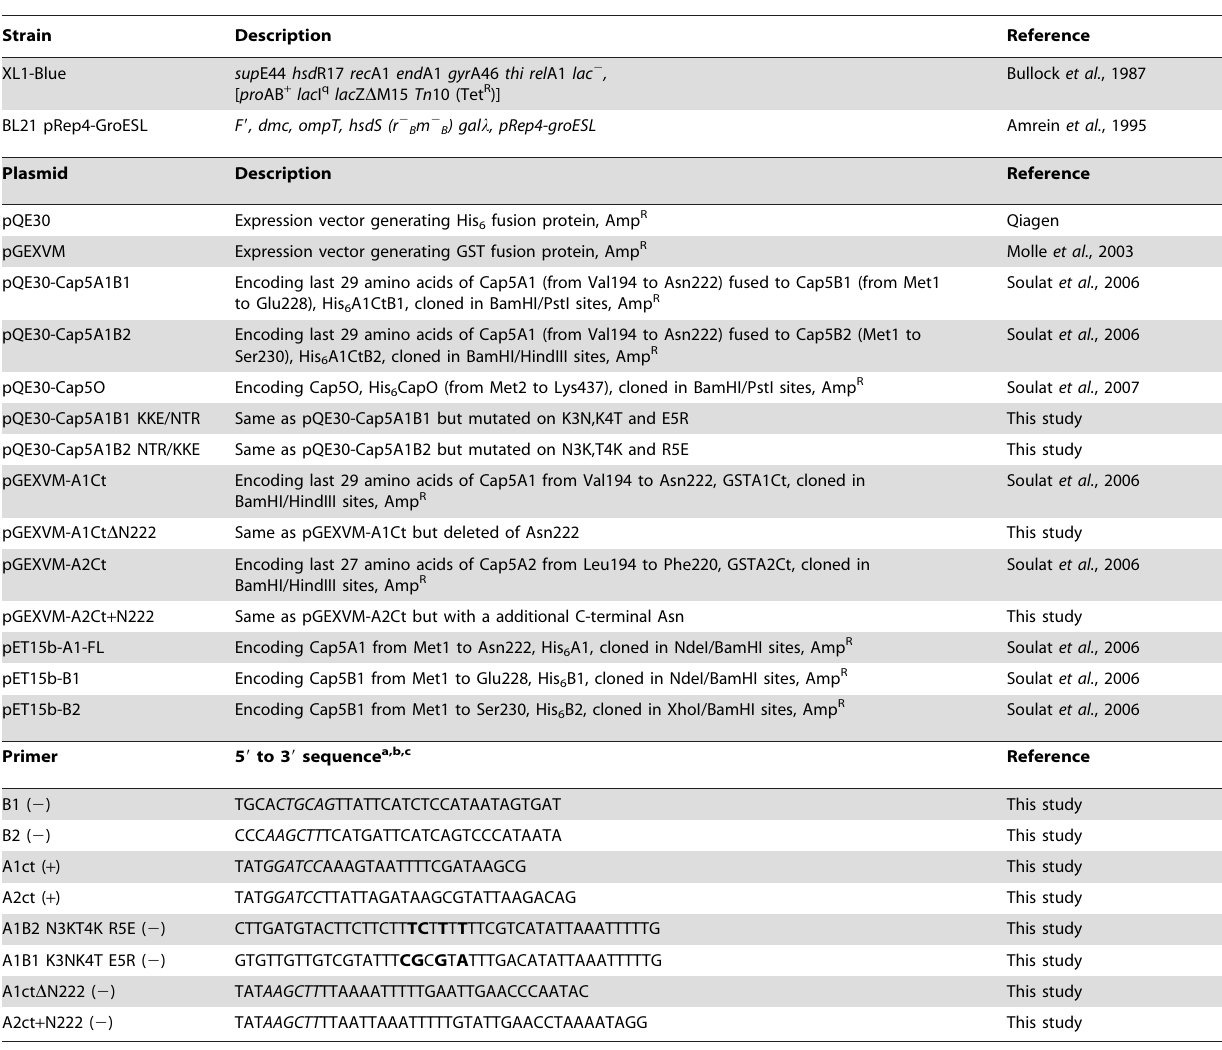
Table 1. Bacterial strains, plasmids and primers used in this study.